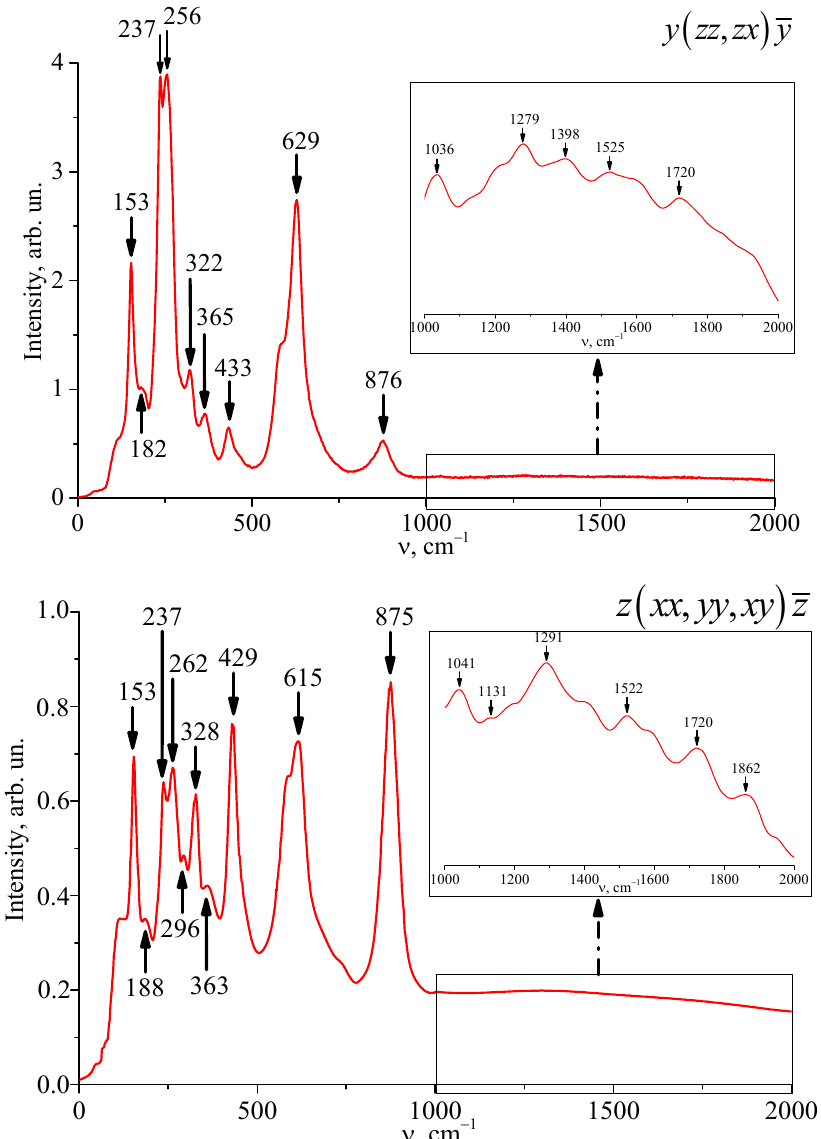
Figure 3. Raman spectra in the band of 50–2000 cm –1 for the backscattering geometry of the LiNbO 3 :Gd 3+ (0.003):Mg 2+ (0.65 wt.%) crystal obtained upon excitation by a laser line with a wave- length of 785 nm. Table 2. The frequencies of transverse (TO) and longitudinal (LO) fundamental polar vibrations observed in the Raman spectrum of the LiNbO 3 :Gd 3+ (0.003):Mg 2+ (0.65 wt.%) crystal obtained in this work, as well as their assignment using [36,37]. Below are the line frequencies corresponding to the second ‐ order spectrum.